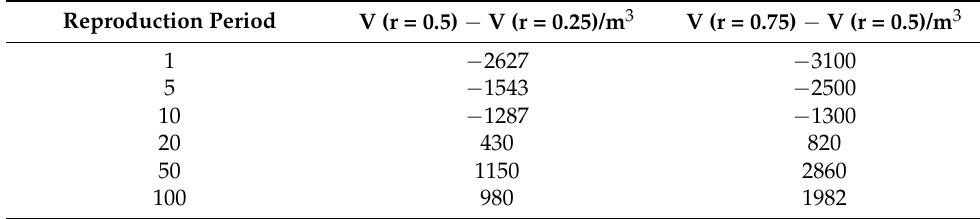
Table 3. Comparison of peak water accumulation at different return periods.